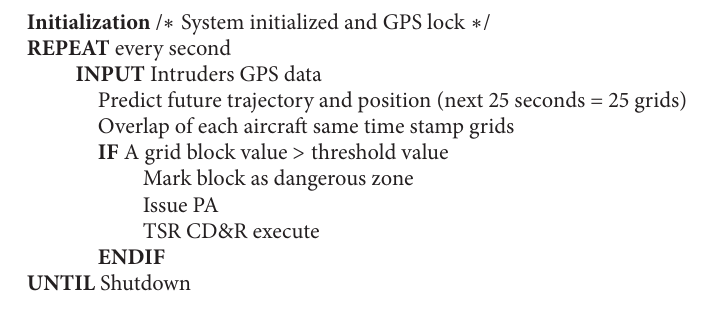
Algorithm 3: PGD CD&R architecture.